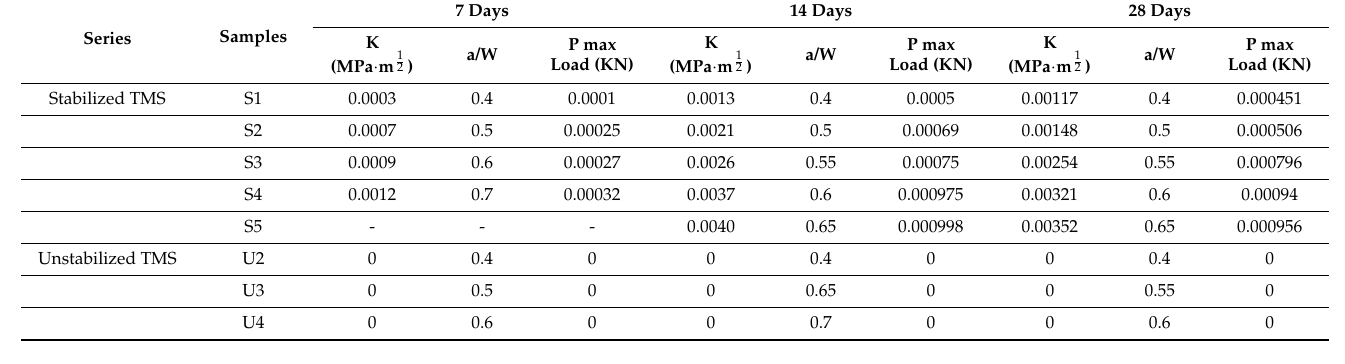
Table 3. Information obtained from the R-curves of unstabilized and stabilized TMS.